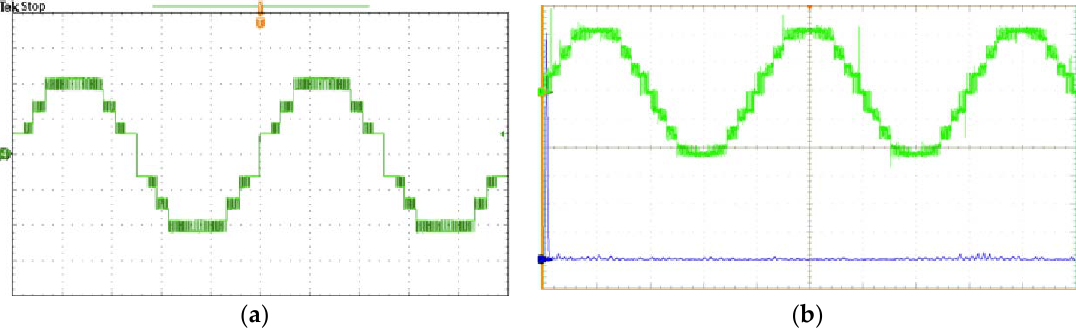
Figure 14. The experimental output voltage in Mode II: no load condition ( a ) without zero level ( b ) with zero level Scale for ( a ): vertical: 50 V/div, horizontal: 4.0 ms/div). Scale for ( b ): vertical: 50 V/div, horizontal: 5.0 ms/div).